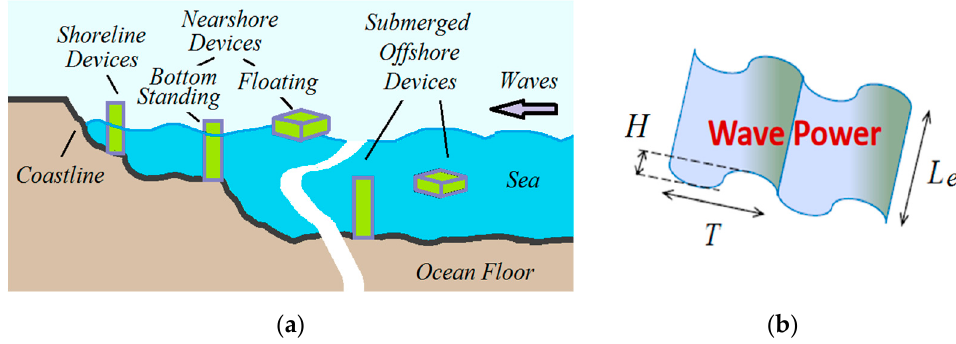
Figure 1. Wave-energy harvesting placements, and wave parameters: ( a ) possible harvesting locations and ( b ) marine wave scheme.